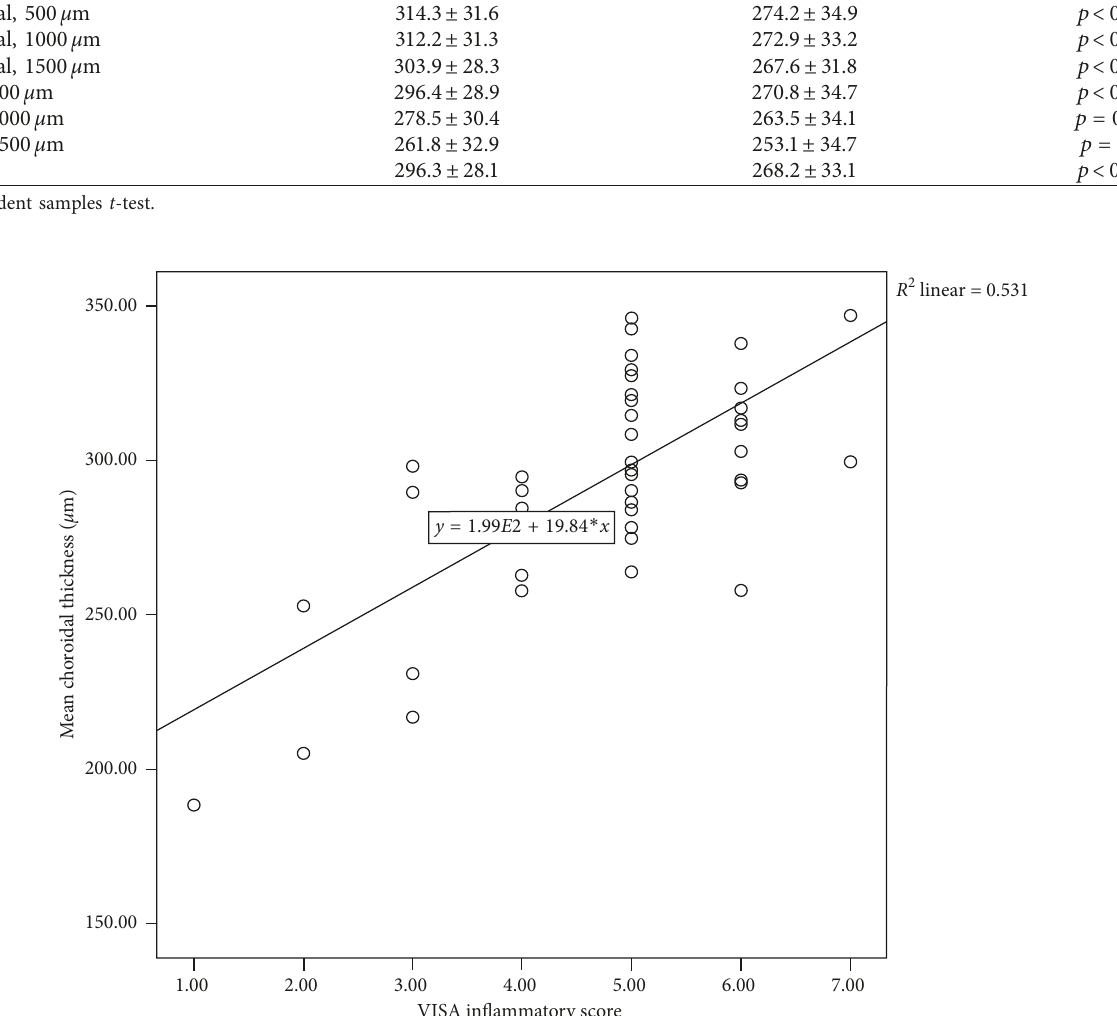
Figure 2: The correlation plot of the mean choroidal thickness and the VISA inflammatory score in patients with Graves’ ophthalmopathy positively correlated with the VISA score ( p � 0 . 001 ; R 2 � 0 .